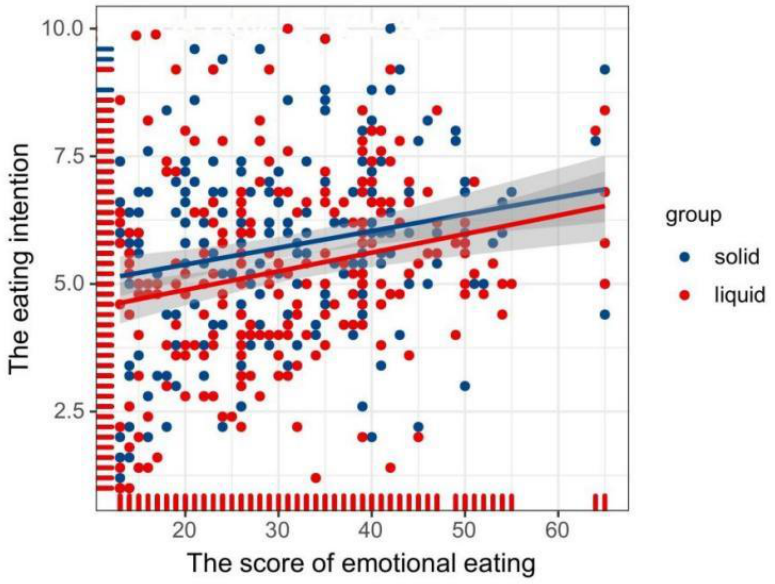
Figure 5. Line regression plot showing the relationship between eating intention with emotional eating scores. Note: Each point represents each participant in the target dataset.